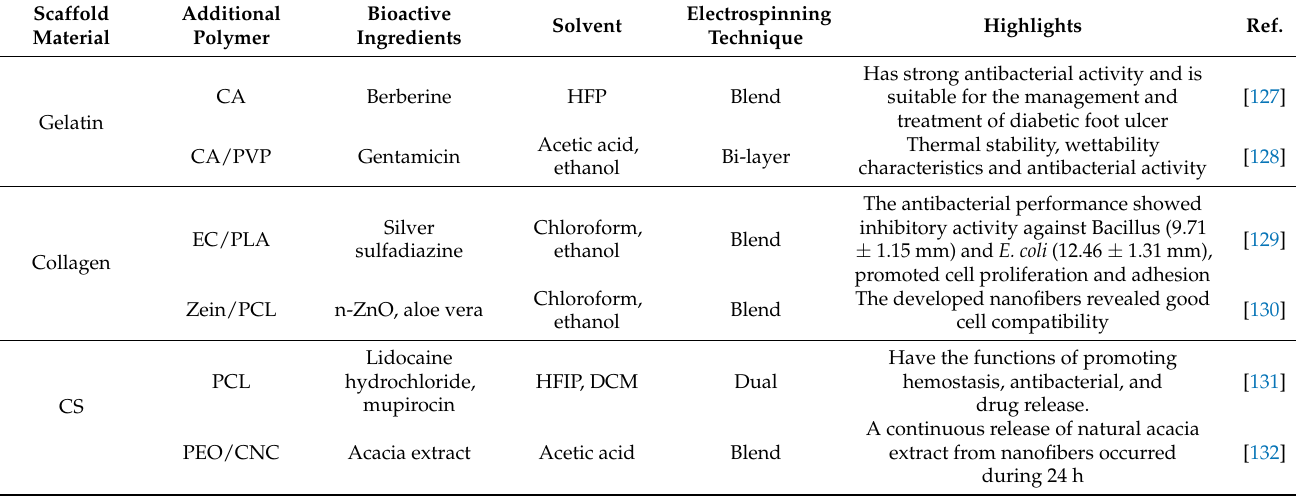
Figure 7. ( A ) PHBV/nCeO 2 nanofiber membrane in cell adhesion, migration and wound healing research [124]; ( B ) the electrospun antibacterial bilayer nanofiber scaffold is used to promote the various characterization analysis of the full-thickness skin defect healing in mice [126]. Table 2. The latest literature on polymer materials and bioactive ingredients used in electrospinning to promote skin wound healing.